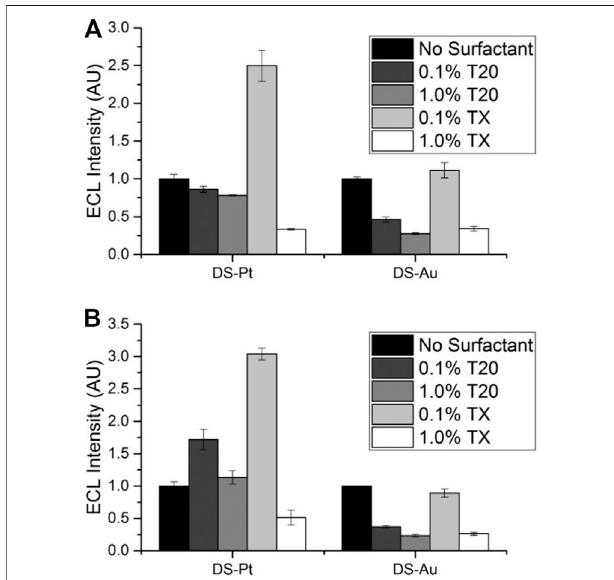
FIGURE 5 | Effect of Tween 20 (T20) or Triton X-100 (TX) surfactants on ECLintensityrelativetothatfromthesameelectrodewithoutsurfactant,0.1 M PBS pH 7.5, 100 mM TPrA. (A) 1 × 10 − 7 M [Ru(bpy) 3 ] 2+ . (B) 1 × 10 − 8 M [Ru(bpy) 3 ] 2+ (n (cid:2)